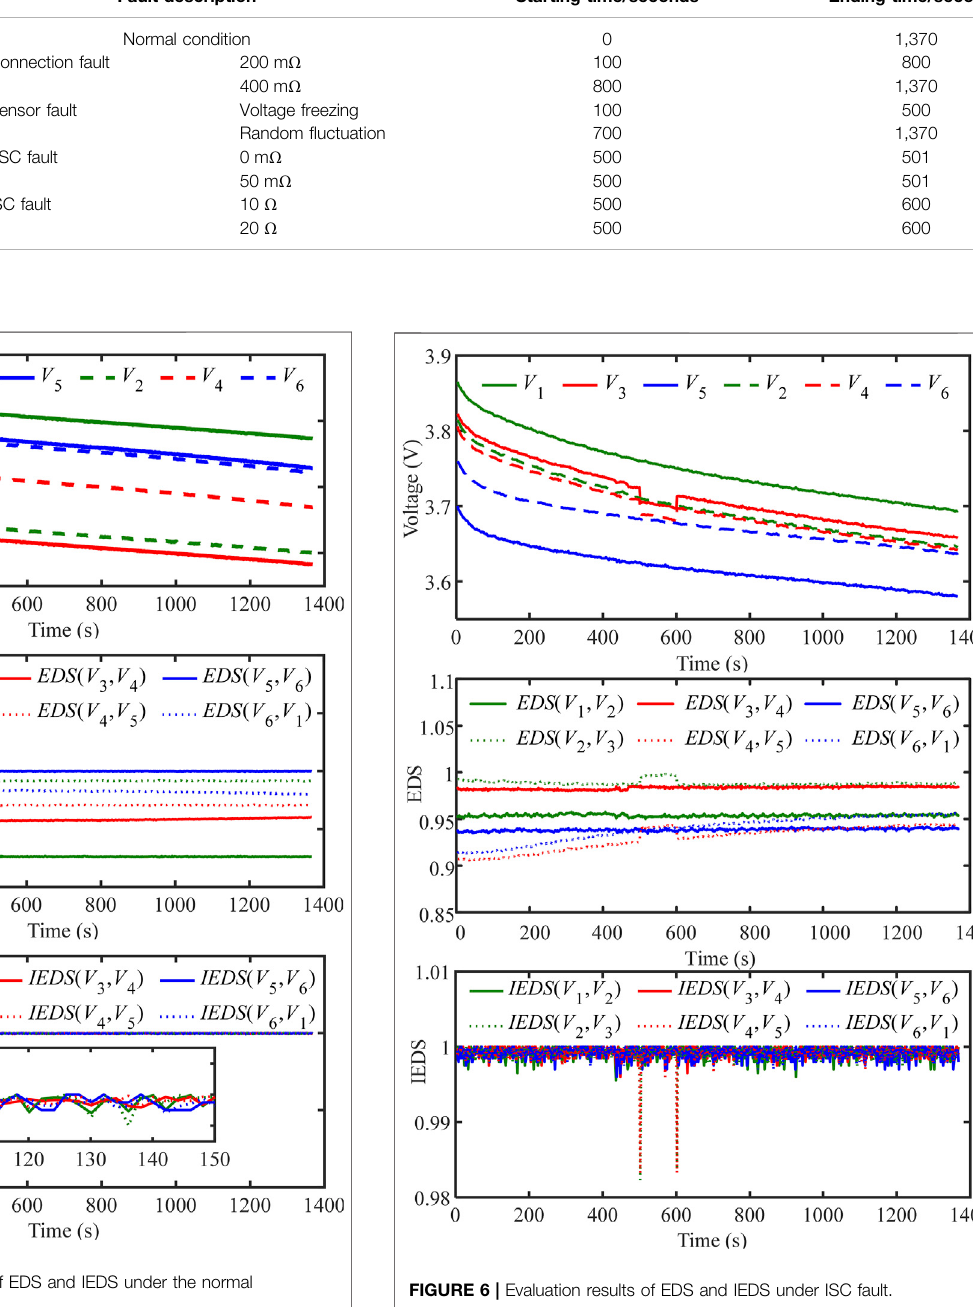
FIGURE 6 | Evaluation results of EDS and IEDS under ISC